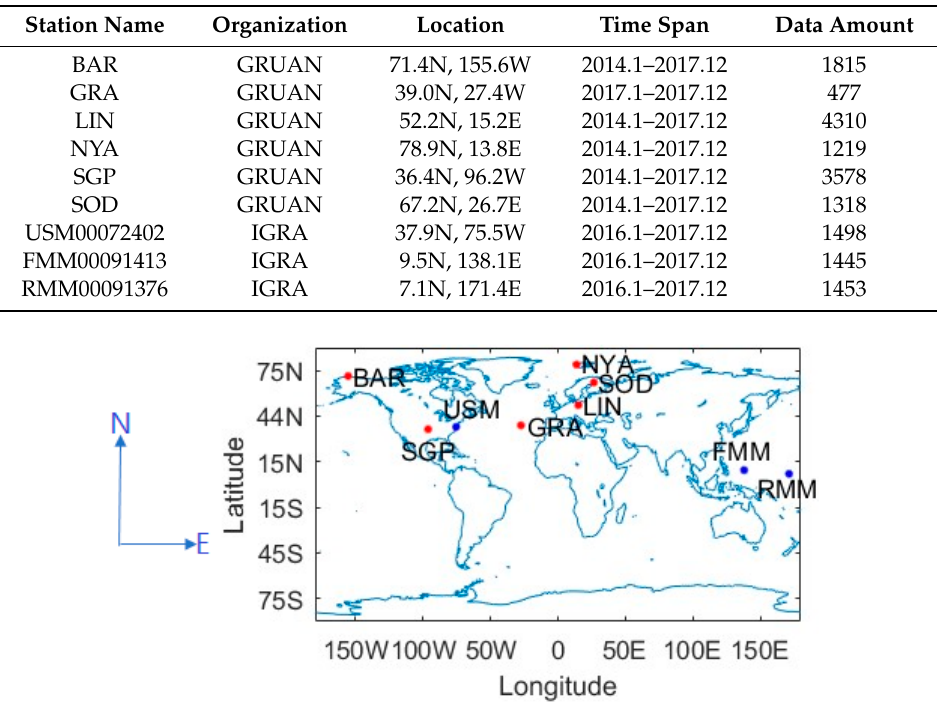
Table 1. Information of radiosonde stations.